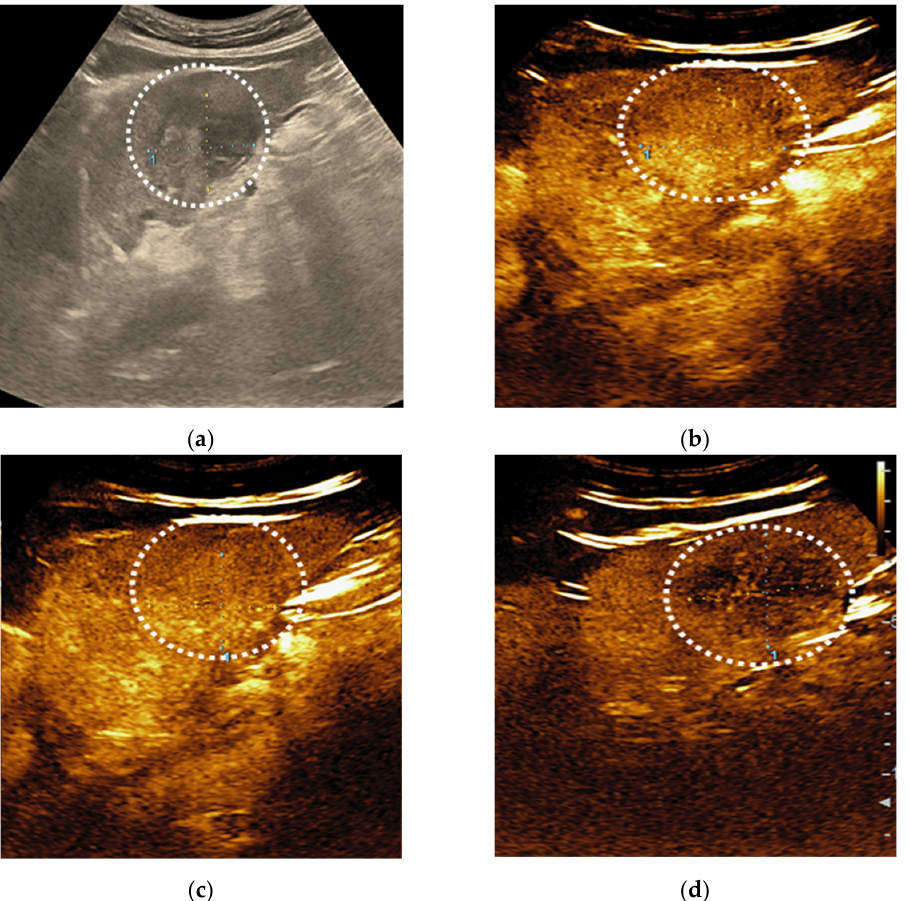
Figure 7. Hepatocellular carcinoma detected in a 54-year-old man with alcoholic cirrhosis, characterised as LI-RADS-5 on CEUS. On B mode ultrasound is observed an inhomogeneous lesion in the right liver lobe ( a ). On CEUS, the liver lesion shows an arterial phase enhancement ( b ) followed by washout appearance that was mild in degree and late in onset ( c , d ).